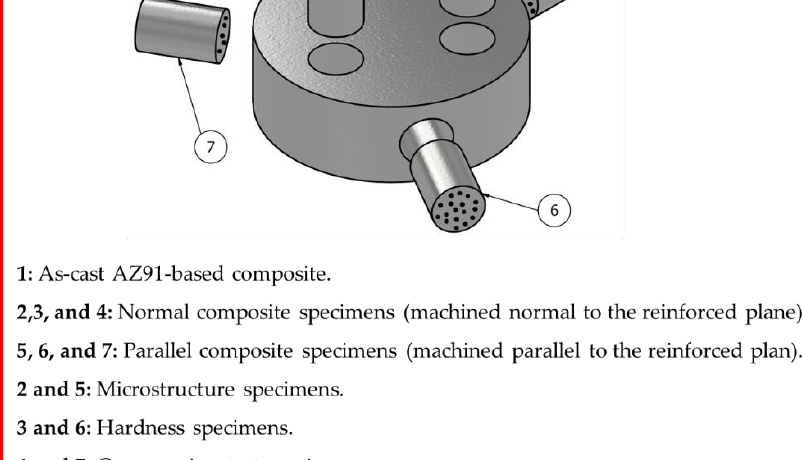
Figure 3. 3D drawing shows the machine directions of the test specimens (as-cast AZ91/23 vol.% short carbon fiber).